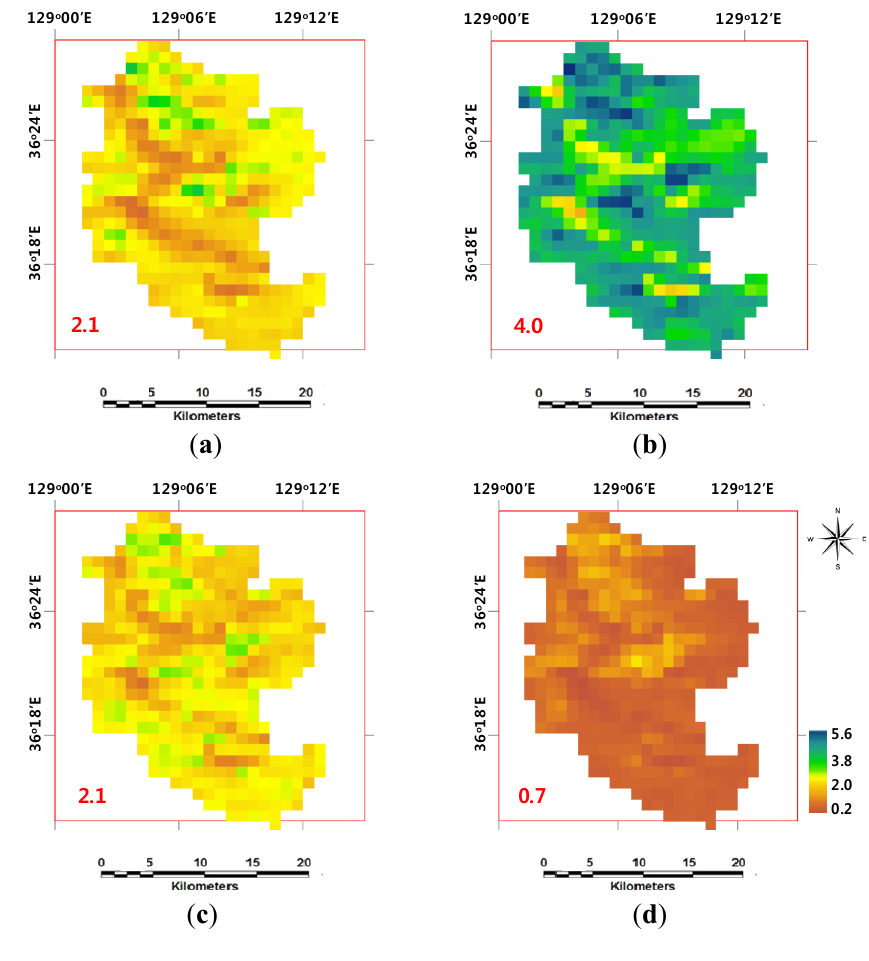
Figure 4. Spatial distributions of 1-km grids and representative values of a 30-km grid (red box and value) for the seasonal average leaf area index (LAI) in ( a ) March-April-May (MAM), ( b ) June-July-August (JJA), ( c ) September-October-November (SON), and ( d ) December-January-February (DJF) over the study